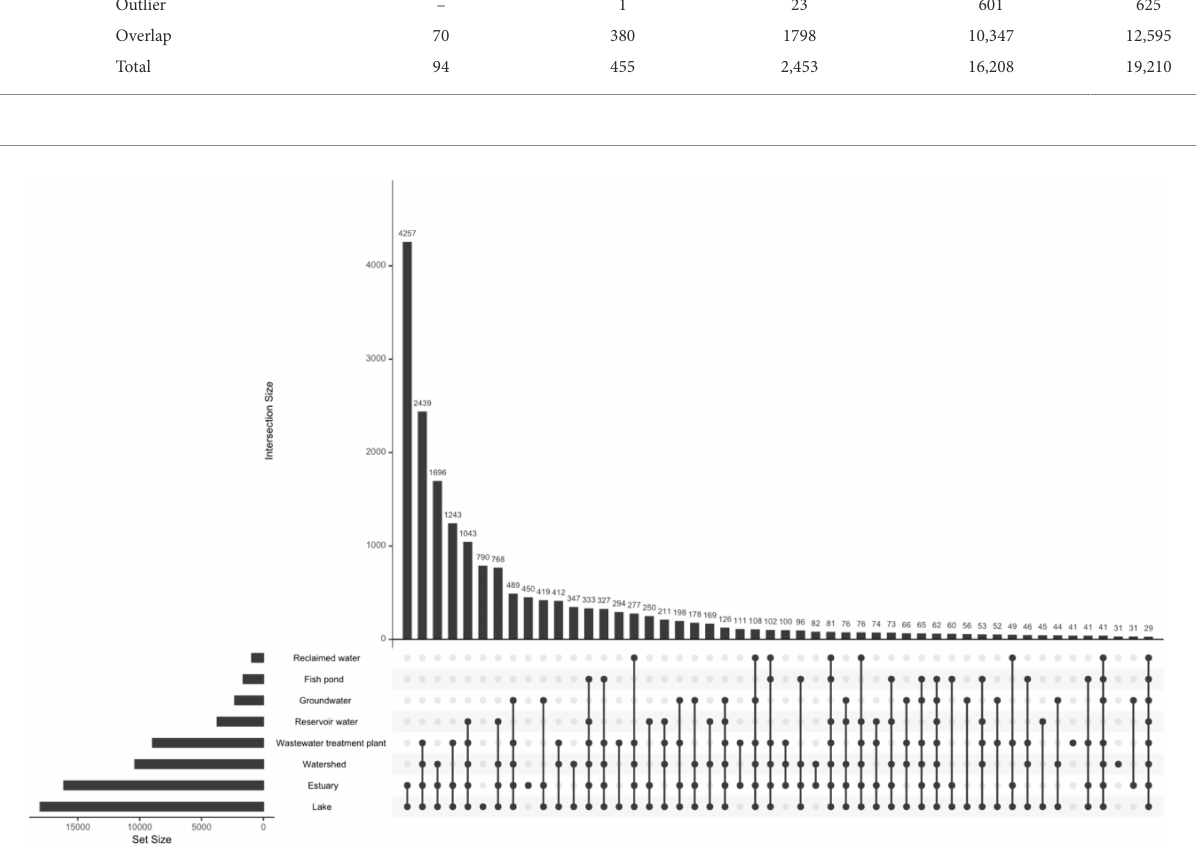
FIGURE 2 Intersection between different biomes based on common contigs with nonzero abundance. The figure was generated using upset function of UpSetR package v.1.4.0 (nsets = 8, order.by = “freq,” nintersects = 50, all other arguments set to default; Conway et al.,